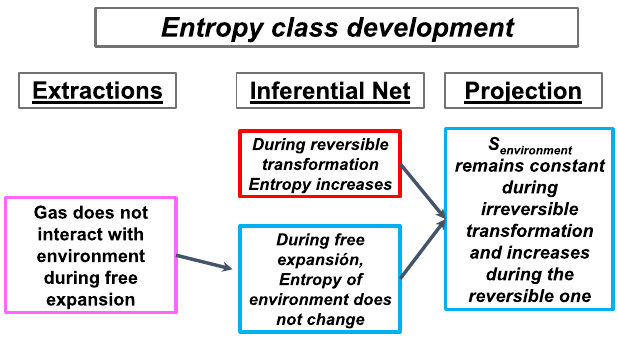
FIG. 10. Class development during segment 4. Purple highlight is used for contributions or changes proposed by both